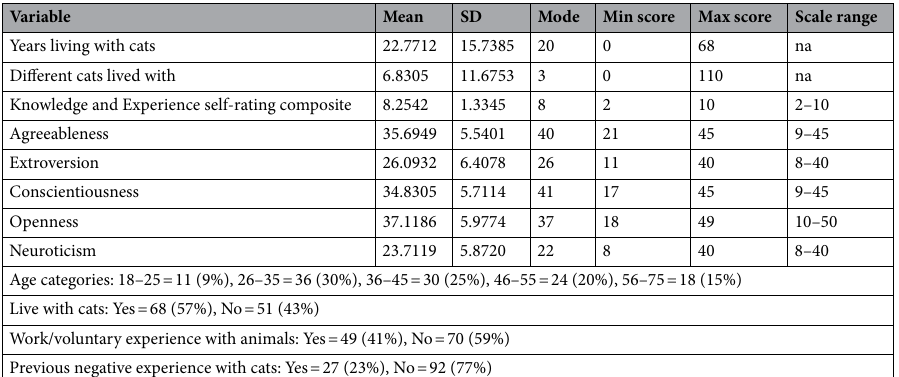
Table 1. Descriptive statistics for the measures collected from participants (n = 119) via the questionnaire (see Supplementary File S1 for a copy), all of which were included as explanatory variables in relevant statistical